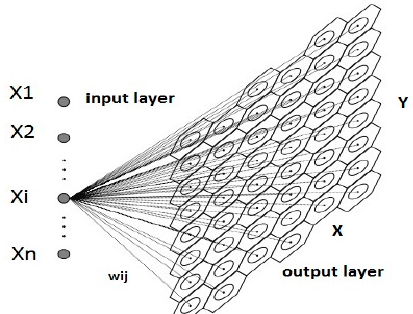
Figure 2. Projection of n-dimensional data into a two-dimensional ( XY ) space (output layer) with the use of a SOM; where X1 , X2 , . . . , Xn are the input variables, n is the input variable’s number, and w ij is the synaptic weight that is connecting the i input variable with the j node.